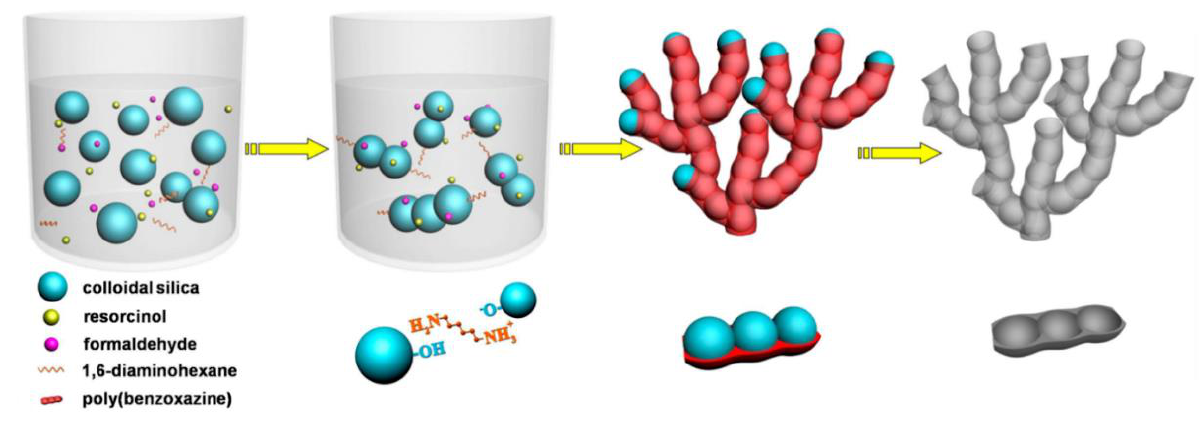
Figure 35. Diagram for the formation process of coral-like carbon (reproduced from the work in [92] with permission). Taking into account the high surface area of combined carbon materials, regular ultra- micropores, and spherical geometry simultaneously, Liu et al. [79] expects an innovative material tailored for high-performance EDLCs. Liu et al. designed and synthesized ultramicroporous@microporous carbon nanospheres (UMCN) with a unique 3D core-shell with the potential to be used as advanced supercapacitor electrodes. By time-controlled polymerization of phloroglucinol and terephthalaldehyde (P/T), polymer colloids were prepared, and then resorcinol/formaldehyde (R/F) copolymerized on the colloid surfaces to fabricate nanospheres. Carbonization and further KOH activation generates regular ultra-micropores in the inner (P/T) cores and abundant micropores in the outer (R/F) shell as depicted in Figure 36.